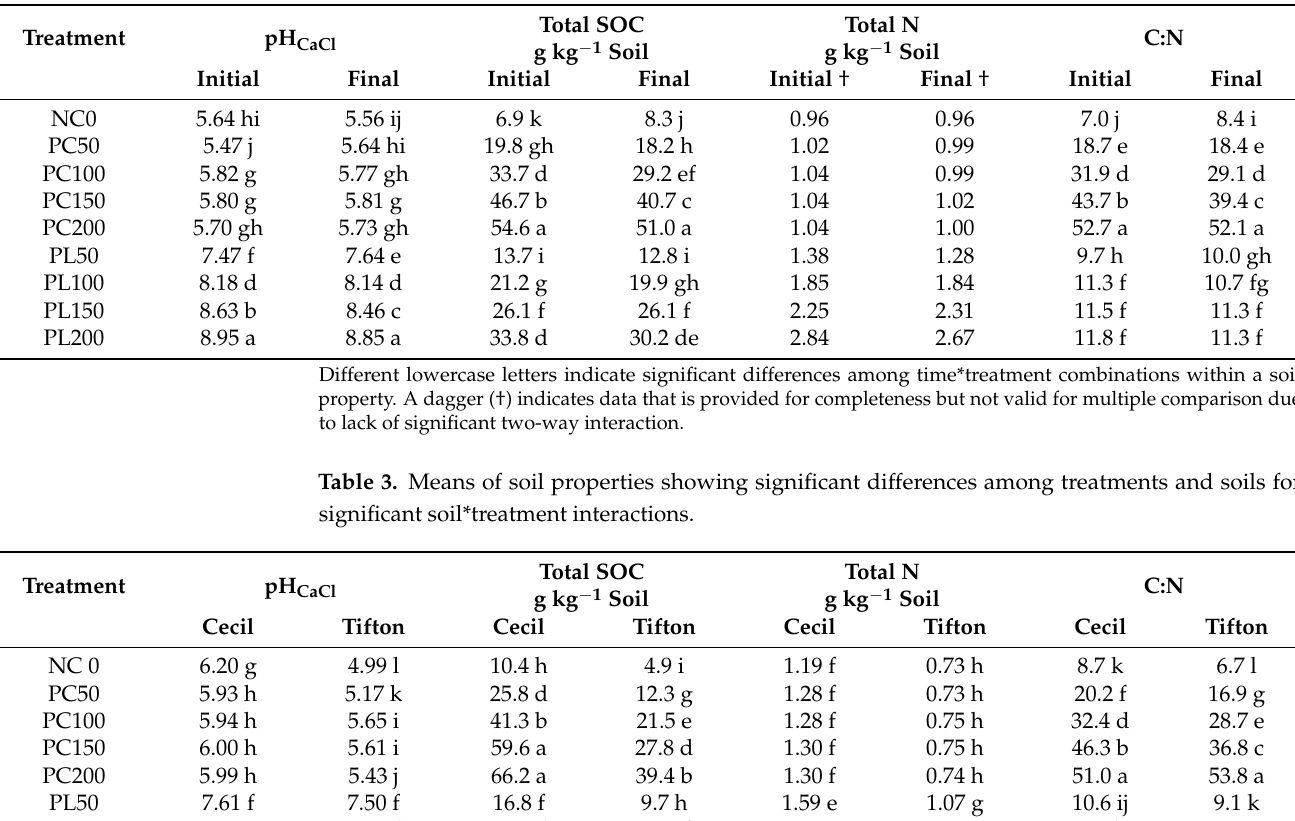
Table 2. Means of soil properties showing significant differences among treatments and soils for significant time*treatment interactions.